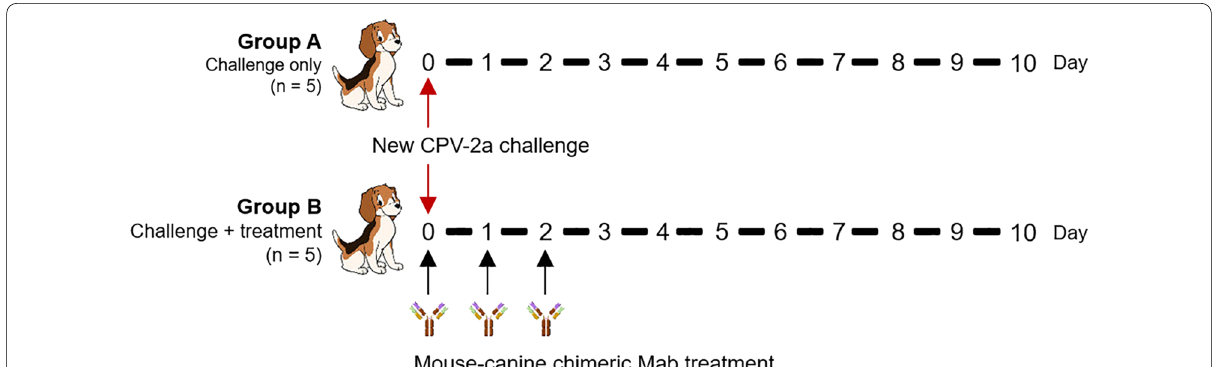
Fig. 2 The design of the therapeutic efficacy study of 11D9 in